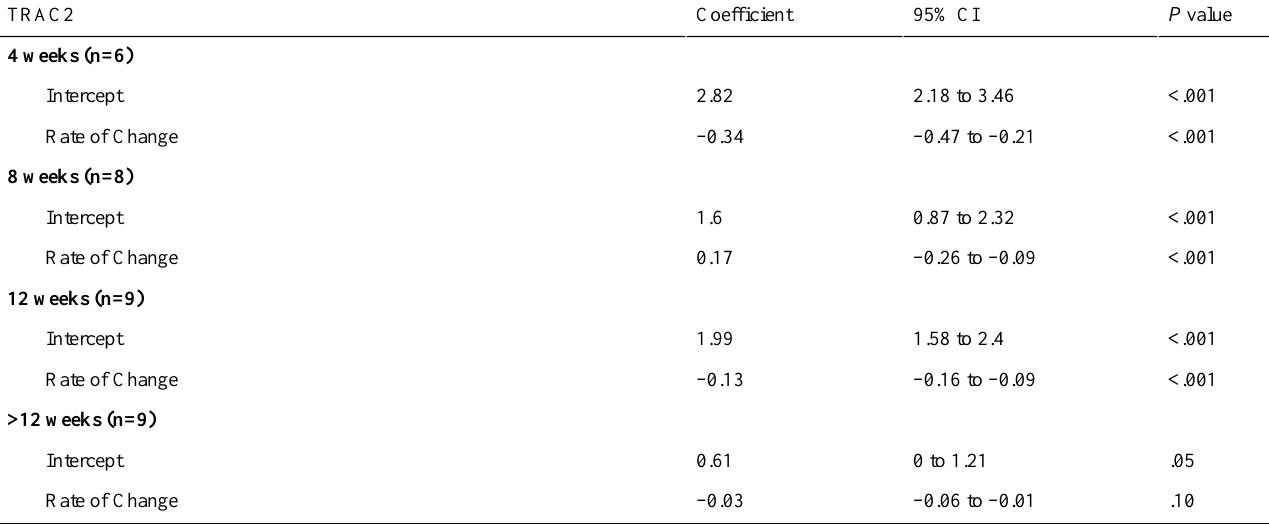
Table 1. Output from Poisson repeated-measures regression models of maximum drinks consumed over weekends using ecological momentary assessment (EMA) reports. Coefficient=beta